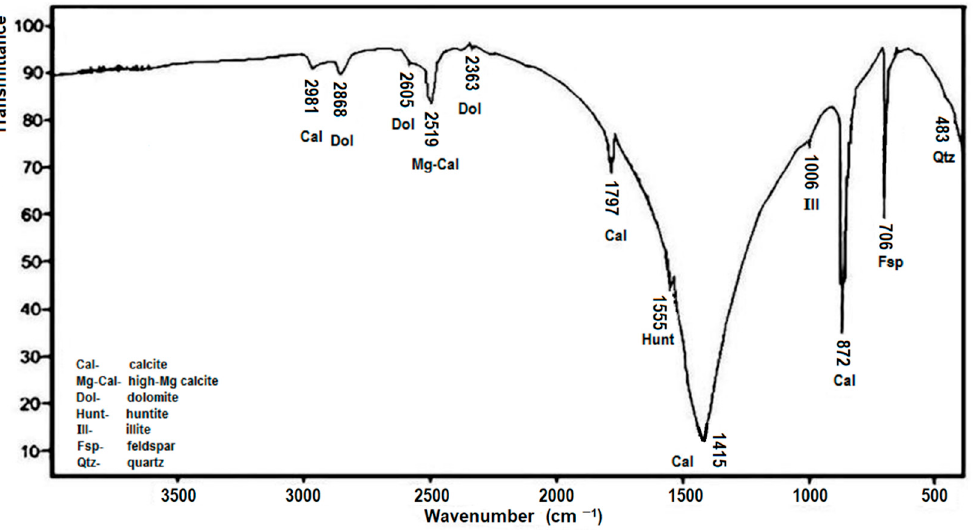
Figure 9. Infra-red absorption spectrum of sample G6, limestone of the Gogolin Unit taken in the Gogolin Quarry [21,22,24].